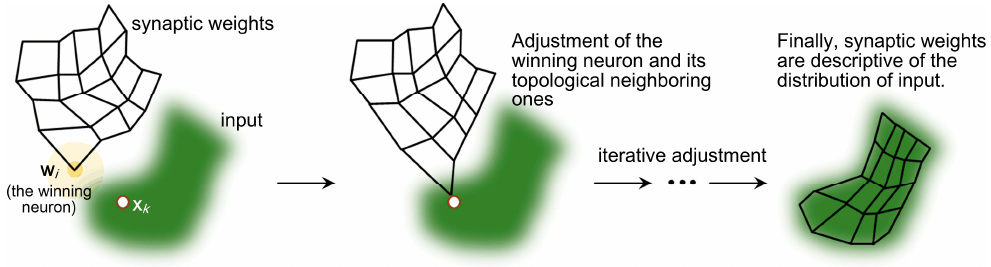
Figure 2. Illustration of the learning process of self-organizing map (SOM).